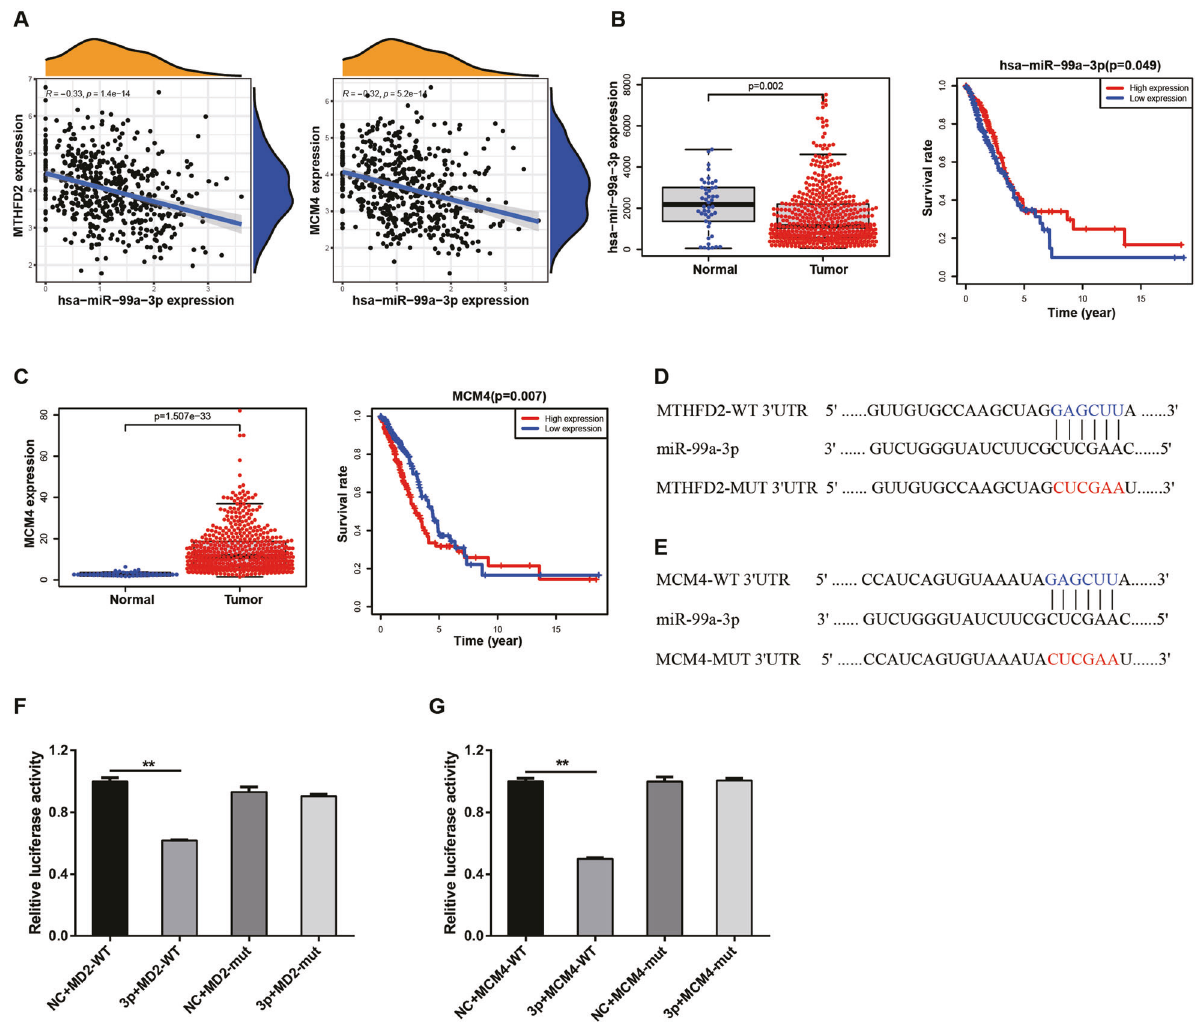
Fig. 5 miR-99a-3p serves as a direct upstream regulator of MTHFD2 in LUAD cells. A TCGA database showed the negative correlation between miR-99a-3p and MTHFD2 and MCM4 . B The relative mRNA levels of miR-99a-3p in LUAD tissues ( n = 483) and normal tissues ( n = 45) based on the TCGA database. Kaplan – Meier survival analysis based on different miR-99a-3p expression levels in LUAD patients was shown at the right panel. C The relative mRNA levels of MCM4 in LUAD tissues ( n = 535) and normal tissues ( n = 59) based on the TCGA database. Kaplan – Meier survival analysis based on different MCM4 expression levels in LUAD patients was shown at the right panel. D , E The putative binding sites for miR-99a-3p in 3' UTR of MTHFD2 and MCM4. F , G Dual luciferase reporter assay indicated the luciferase activities of MTHFD2- WT/MUT and MCM4-WT/MUT using NC mimics or miR-99a-3p mimics overexpressed A549 and H1299 cells. ** P <